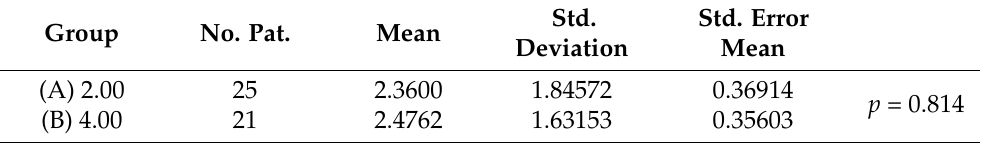
Figure 1. S tatistical analysis of prosthetic aftercare; 2 and 4 implants, pressure sores. Figure 1. Statistical analysis of prosthetic aftercare; 2 and 4 implants, pressure sores. Table 2. t -test liner exchange.